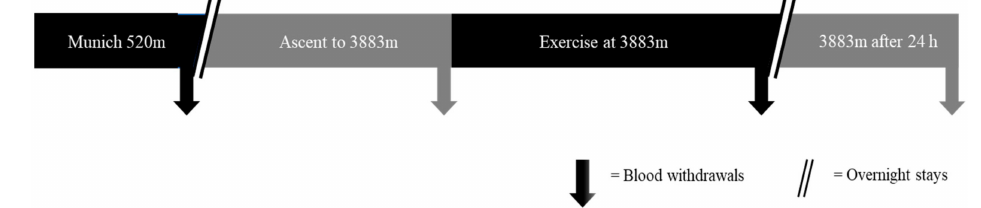
Figure 7. Study protocol for expedition trial. Blood withdrawal and clinical analyses were performed at baseline (Munich 520 m a.s.l.), upon arrival at 3883 m a.s.l. (Ascent to 3883 m), following 90 min of endurance training (Exercise at 3883 m) and after 24 h at 3883 m a.s.l (3883 m after 24